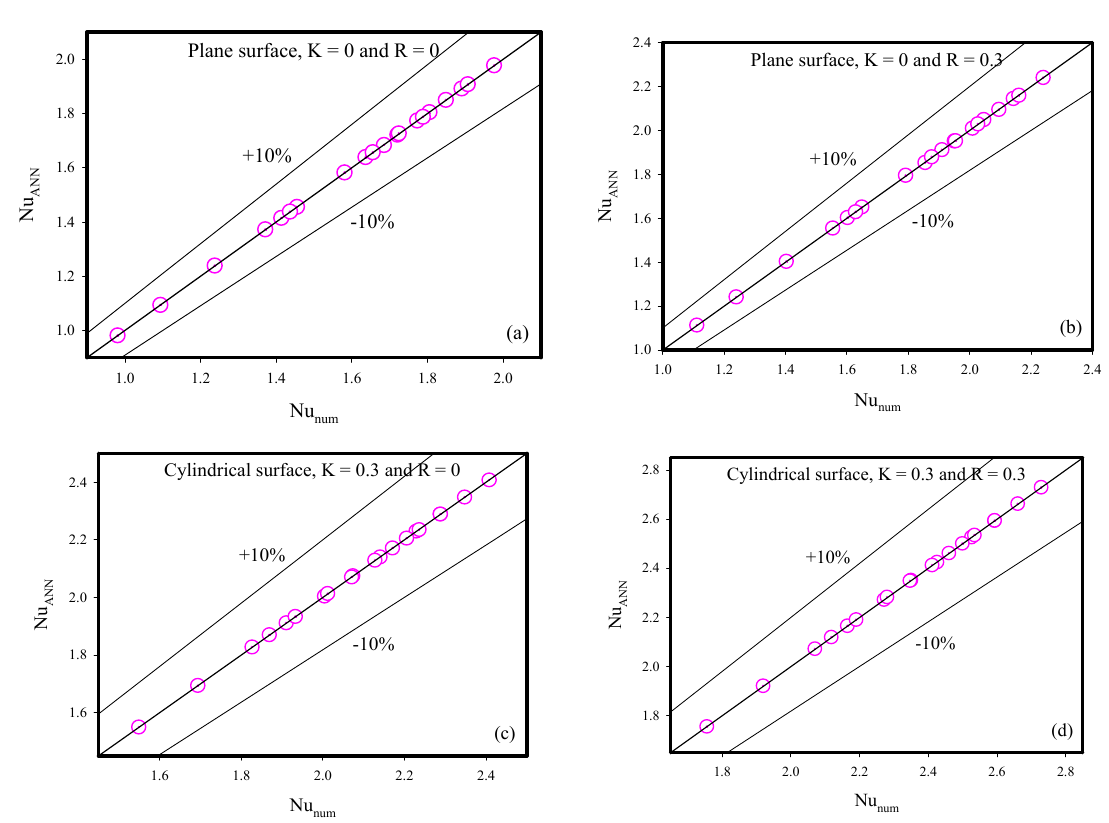
Table 6. For two different examples where the Prandtl number is Pr = 1.5 and Pr = 0.5, the numerical values of the Nusselt number are obtained by altering the velocity ratio parameter. We saw a decent match in both instances, which gives us confidence in the present numerical results.